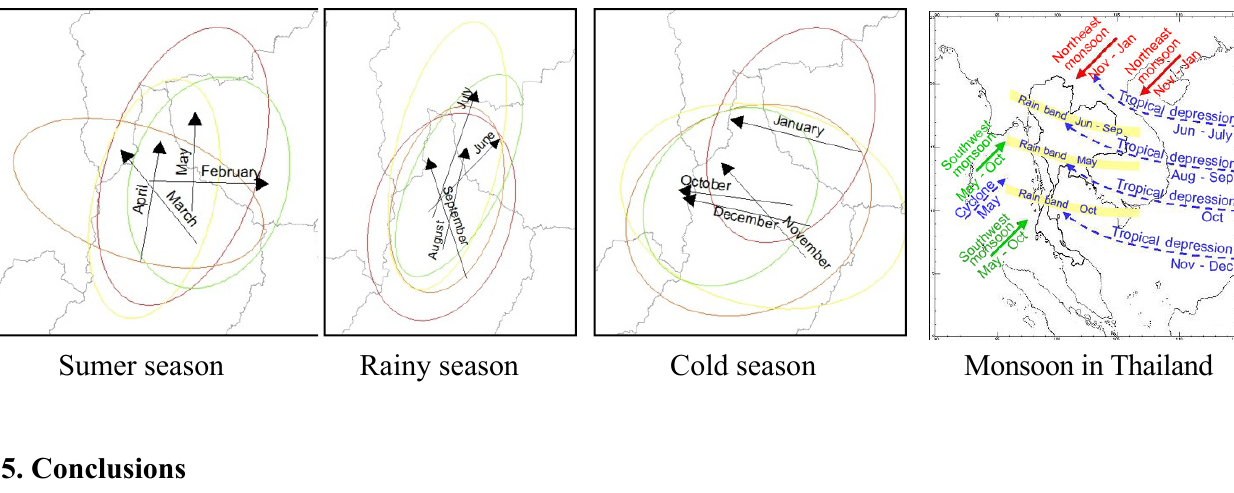
Figure 12. Linear directional mean for each season and the annual monsoon direction in Thailand.